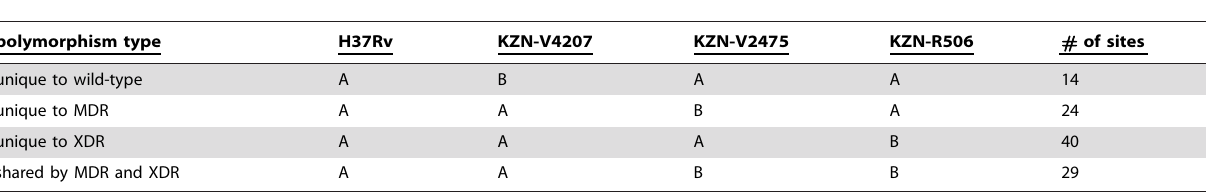
Table 2. Summary of polymorphisms observed in KZN strains.